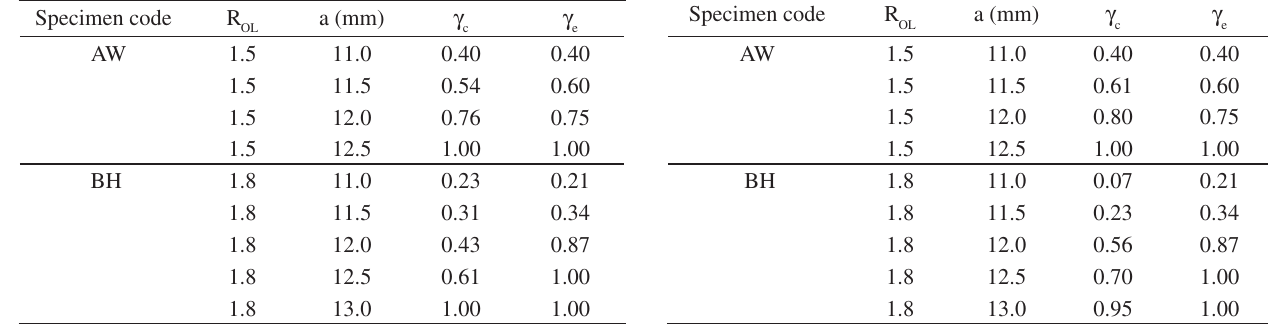
Table 4. Experimental and Wheeler-predicted values of the retardation factor at different crack length increments within the delay zone. Specimen code